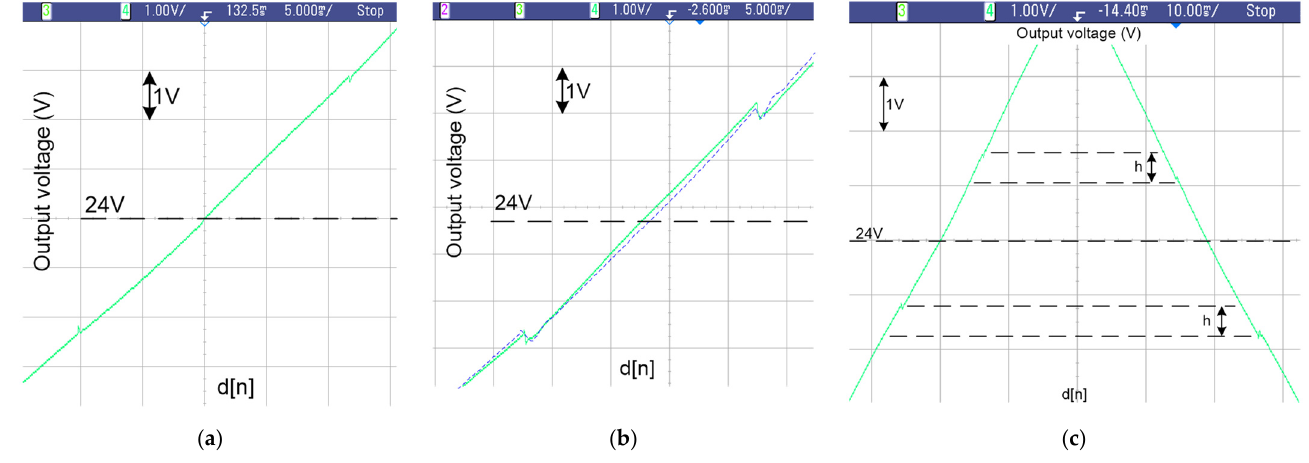
Figure 18. Experimental results. ( a ) Using the ideal implementation (Table 2). ( b ) Using the proposed simplified method (Table 5) with d buck,max = 0.9 and d boost,min = 0.1. ( c ) Using d buck,max = 0.95 and d boost,min = 0.05 and showing the hysteresis effect.